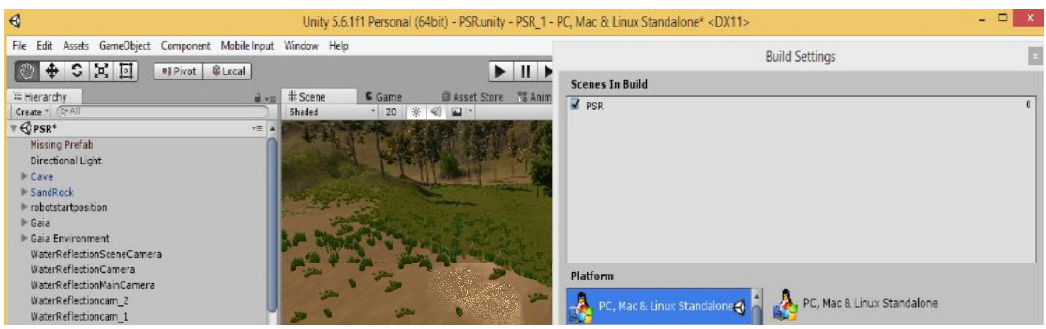
Figure 4. Importing the Gaia environment in Unity 5 and the Operating System (OS) selection.